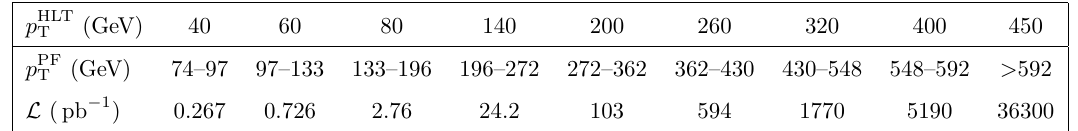
Table 3 . The HLT ranges and effective integrated luminosities used in the jet cross section mea- surement for R = 0 . 4 . The first (second) row shows the p reconstruction; the third row corresponds to the effective luminosity of each trigger L